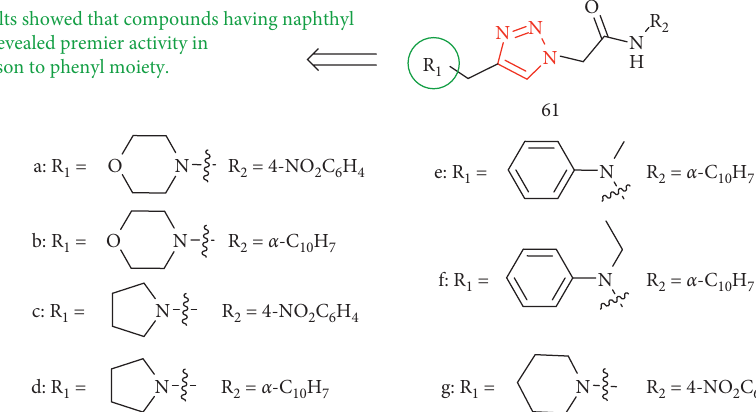
Figure 17: Chemical structure of amine-amide-linked 1,4-disubstituted